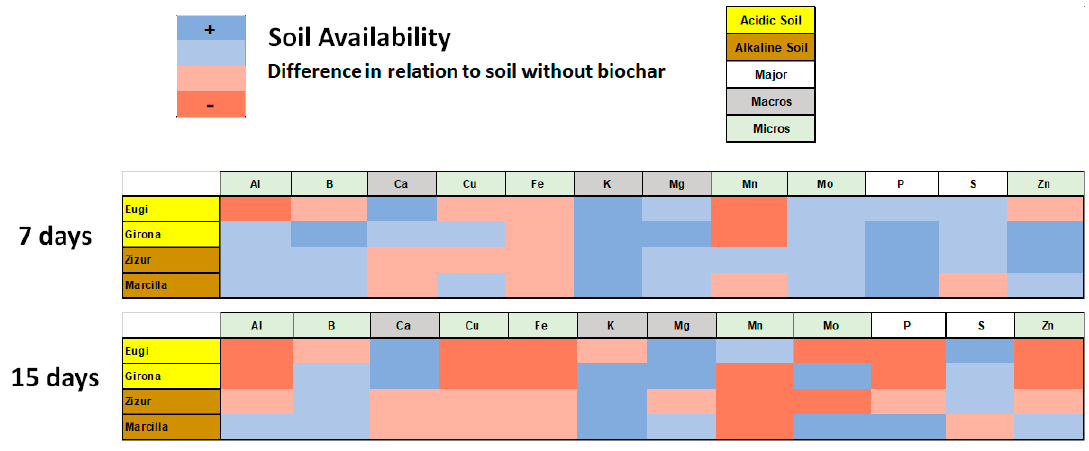
Figure 3. Desorption data for Pi-Al-biochar and Pi-Fe-biochar complexes. Al, Fe, and Pi percentages were relative to the 1000 mg l − 1 of each element added.